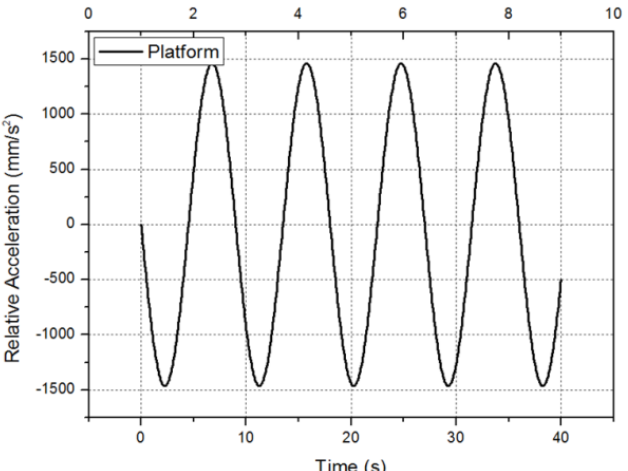
Figure 13. Acceleration of heave.